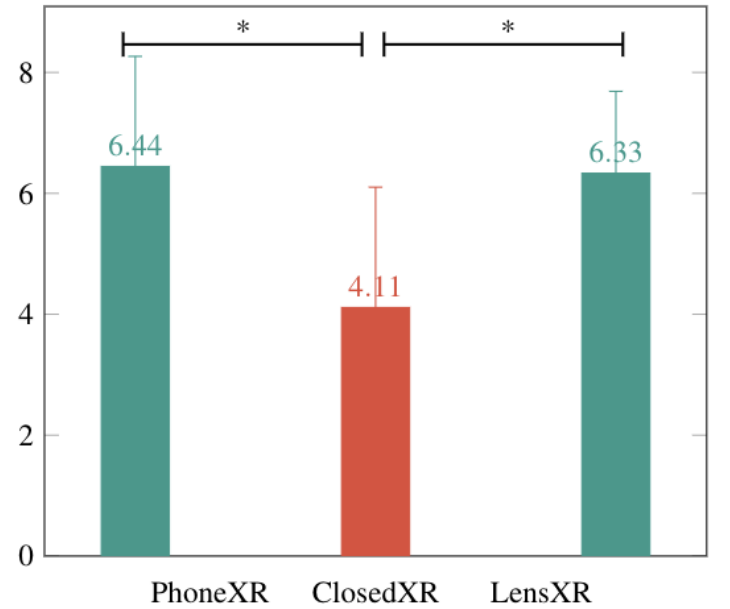
Figure 12. Survey results regarding the UX for 2D applications. Statistical differences are indicated by color grouping and the “*” mark. The vertical axes represent the subjective levels in the 7-point Likert